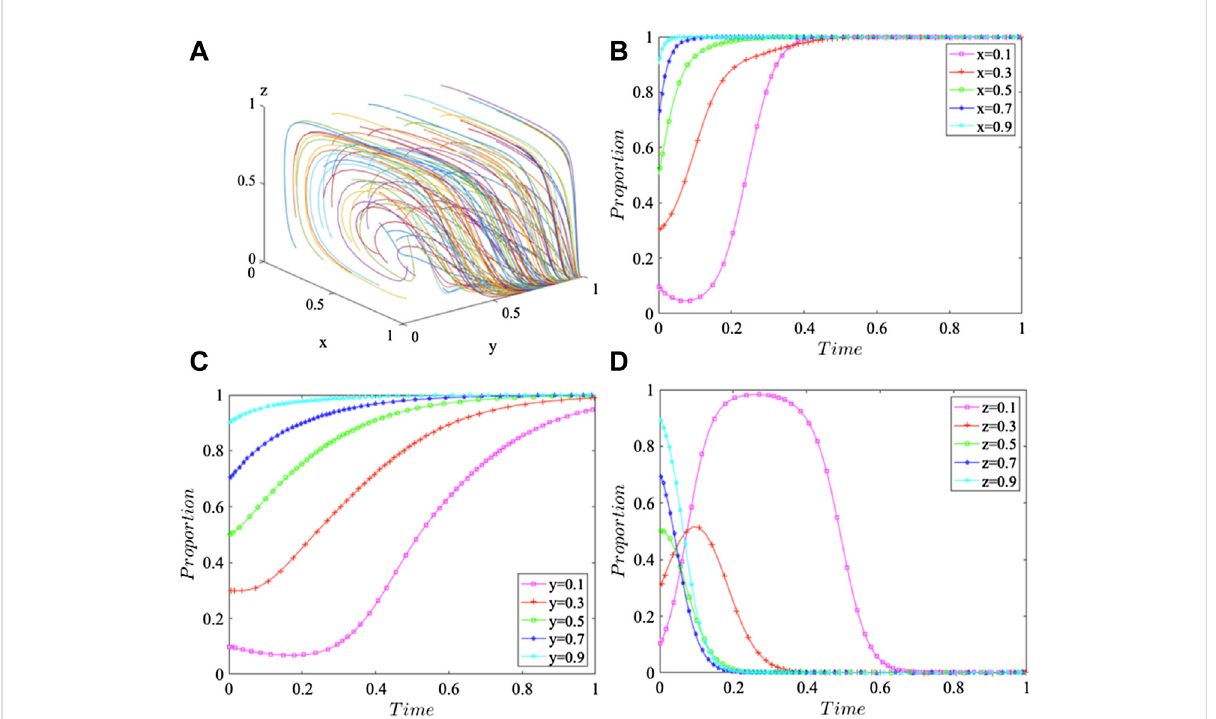
FIGURE 6 Results of three parties with different initial selection probabilities. (A) Results of ESS with different initial selection probabilities, (B) evolutionary gameresultsofpowerbatterymanufacturersunderdifferentinitialselectionprobabilities, (C) evolutionarygameresultsofrecyclingenterpriseunder different initial selection probabilities, (D) evolutionary game results of government under different initial selection